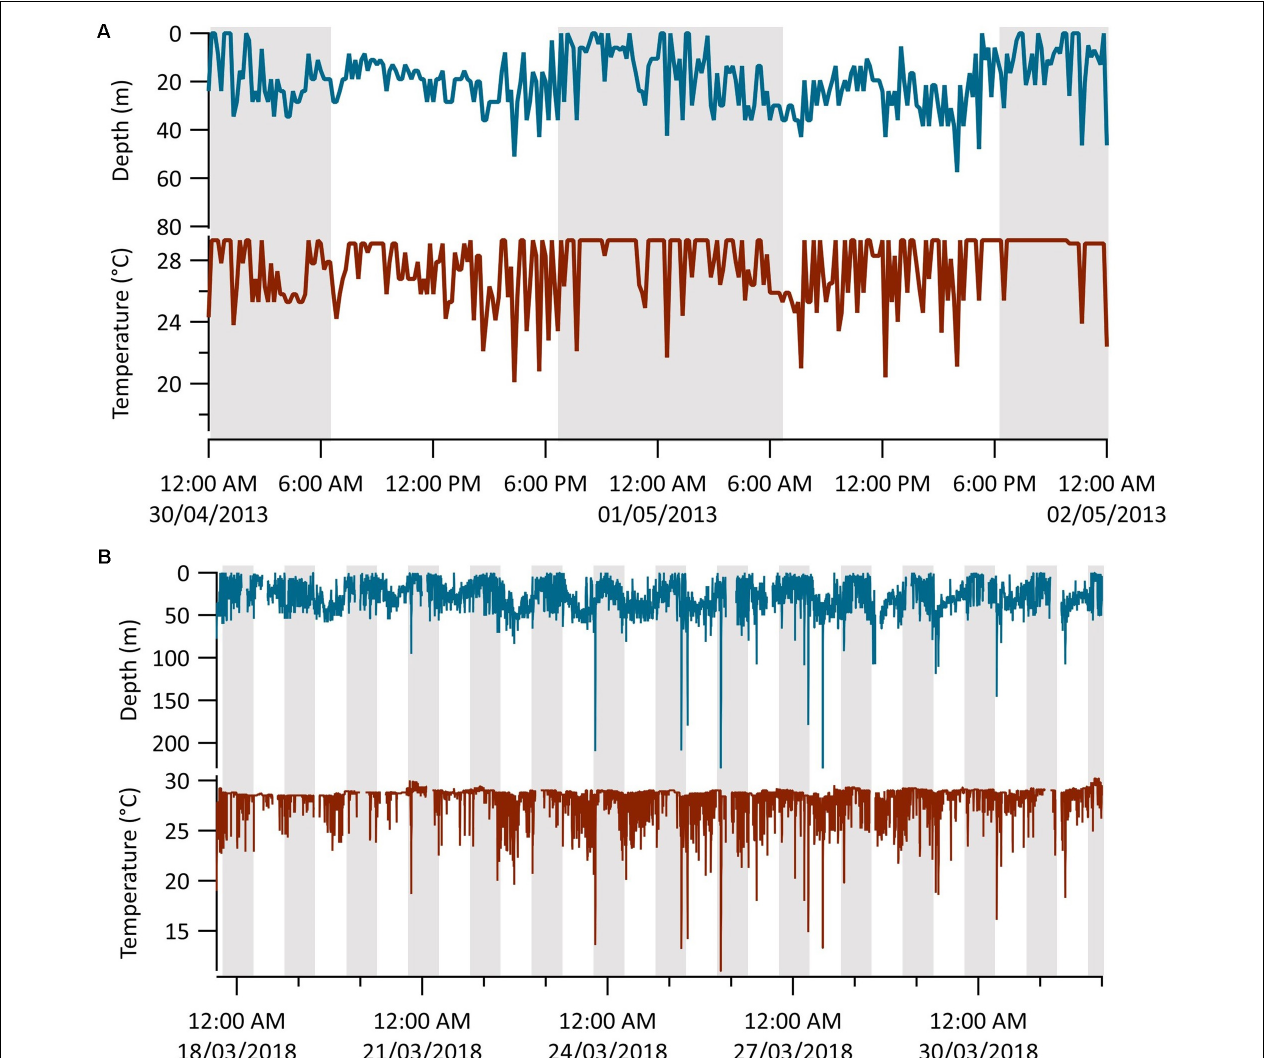
FIGURE 5 | MiniPAT depth (blue) and temperature (red) time-series data from tags deployed on two silky sharks ( Carcharhinus falciformis ) tagged around the Chagos Archipelago. Gray shaded areas represent night-time (19:00–07:00) and white daytime (07:00–19:00). (A) Representative diel vertical movements of shark 1 over 2 days. (B) The entire transmitted depth and temperature series from shark